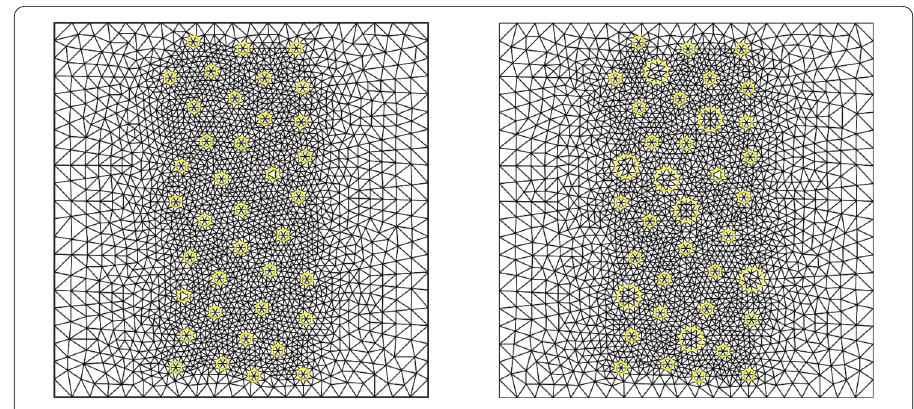
Figure 3 Mesh used for the simulations corresponding to the geometries in Fig. 2